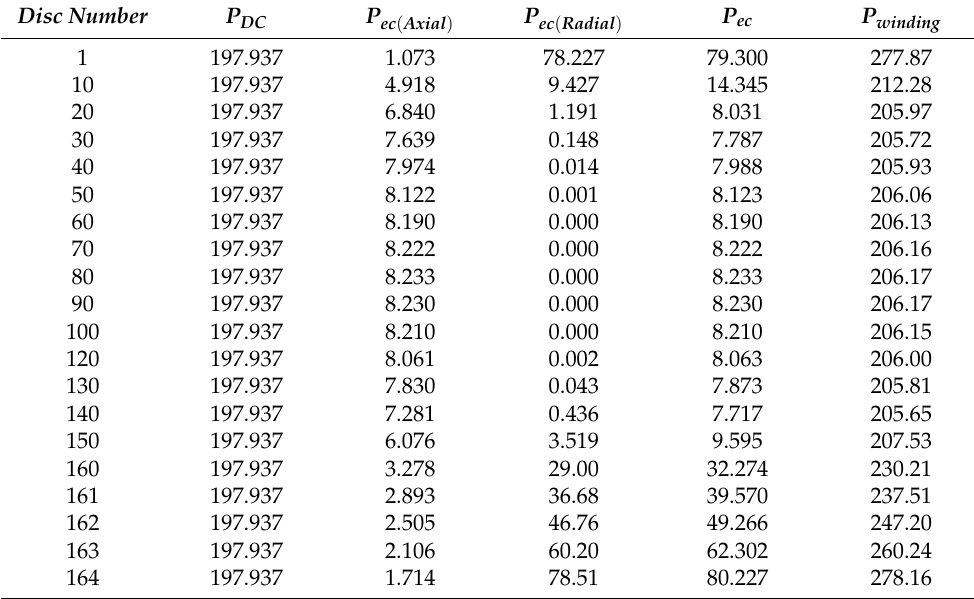
Table 2. Estimated losses per disc (W/m) on the LV winding—Case 1.